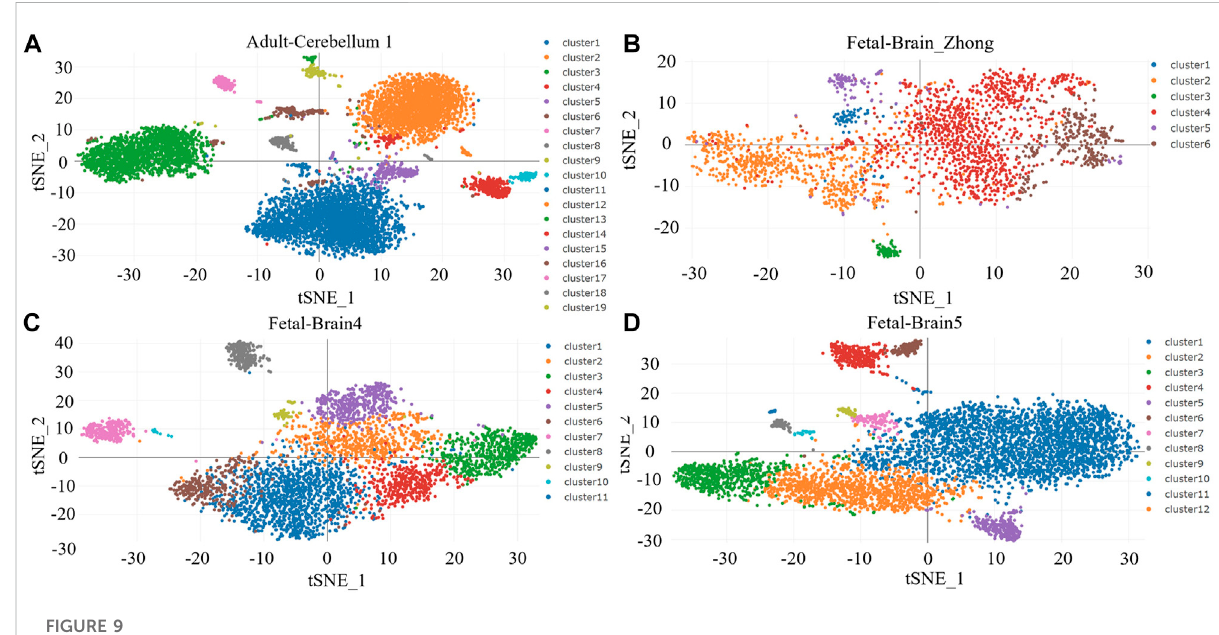
FIGURE 9 (A – D) Clustering analysis for brain tissues.